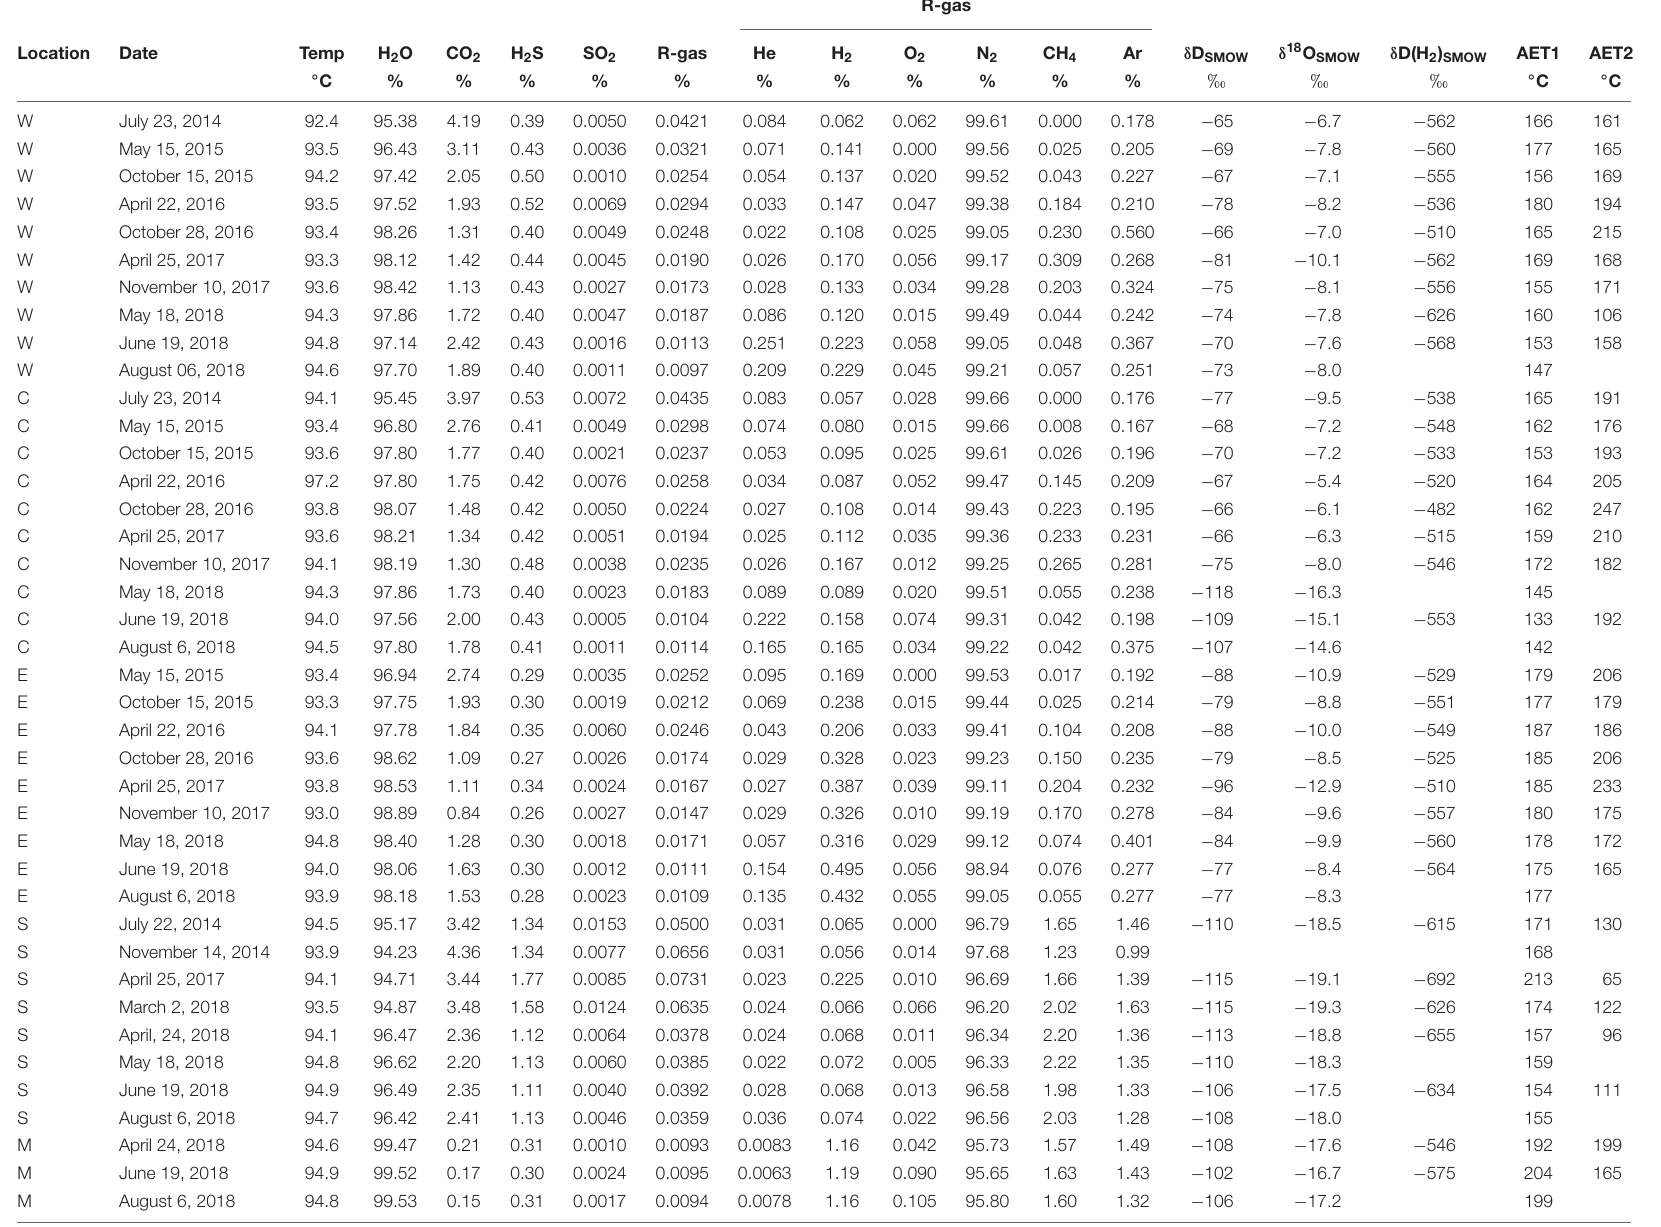
TABLE 2 | Chemical and isotopic composition of fumarolic gasses with the apparent equilibrium